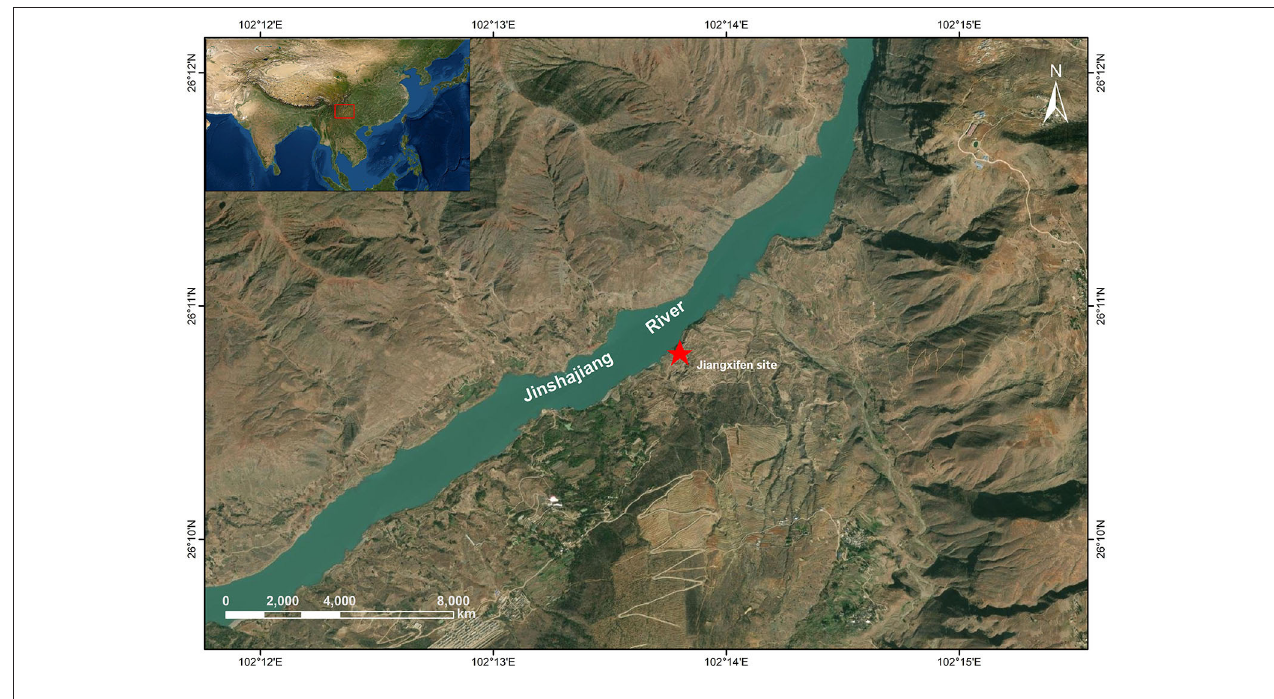
FIGURE 1 | Location of the Jiangxifen site. TABLE 1 | Radiocarbon dates at the Jiangxifen site. Lab no. Sample